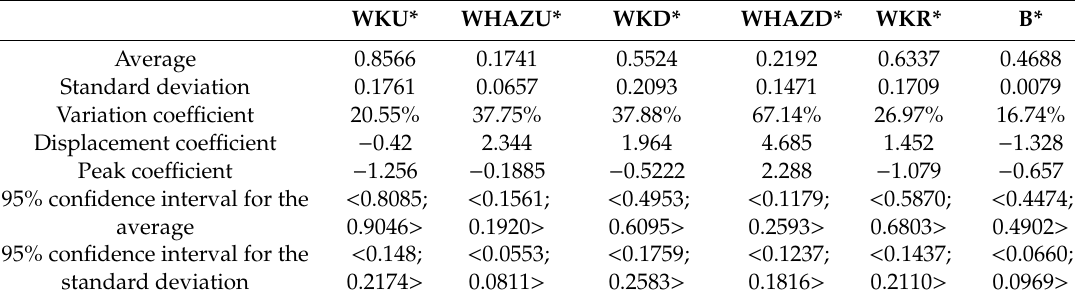
Table 3. Descriptive statistics for transformed values of all